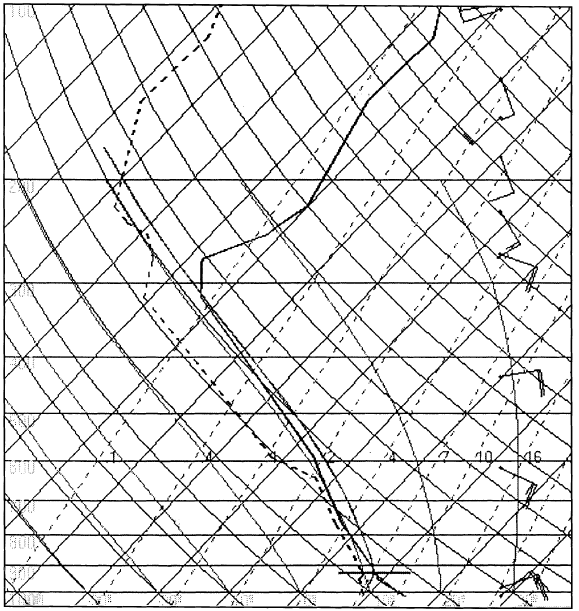
Fig. 13. Time series of CAPE ( dashed line ) and CIN ( solid line ) values during the prestorm and storm regimes. Both parameters are in J kg )